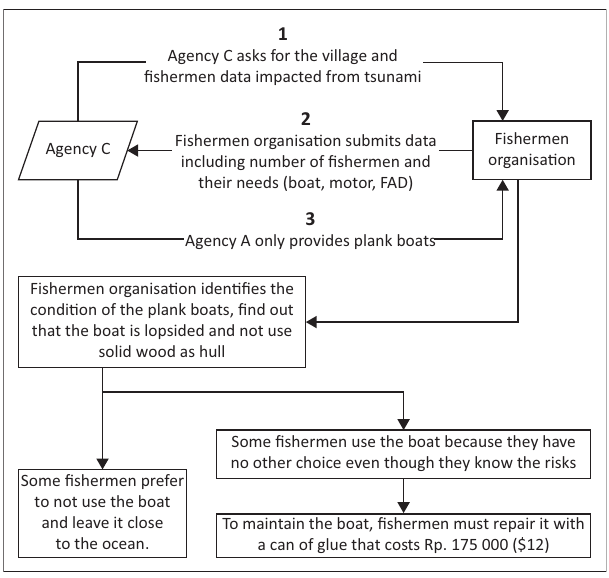
FIG URE 4: Management flow diagram on the practice of agency-driven recovery by Agency C.